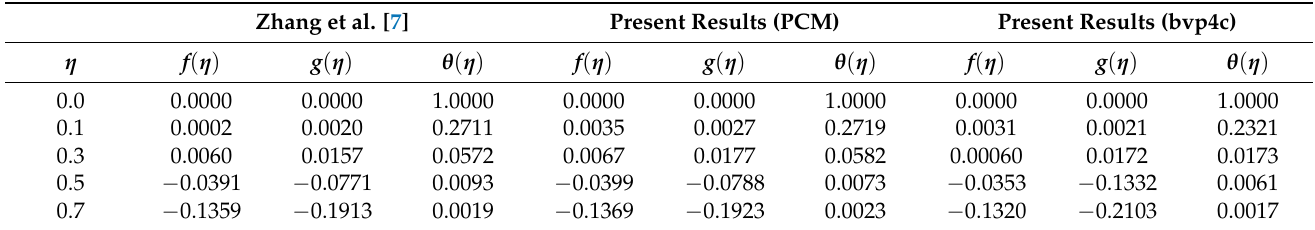
Table 3. Comparative assessments of the present work with the existing study and bvp4c method.